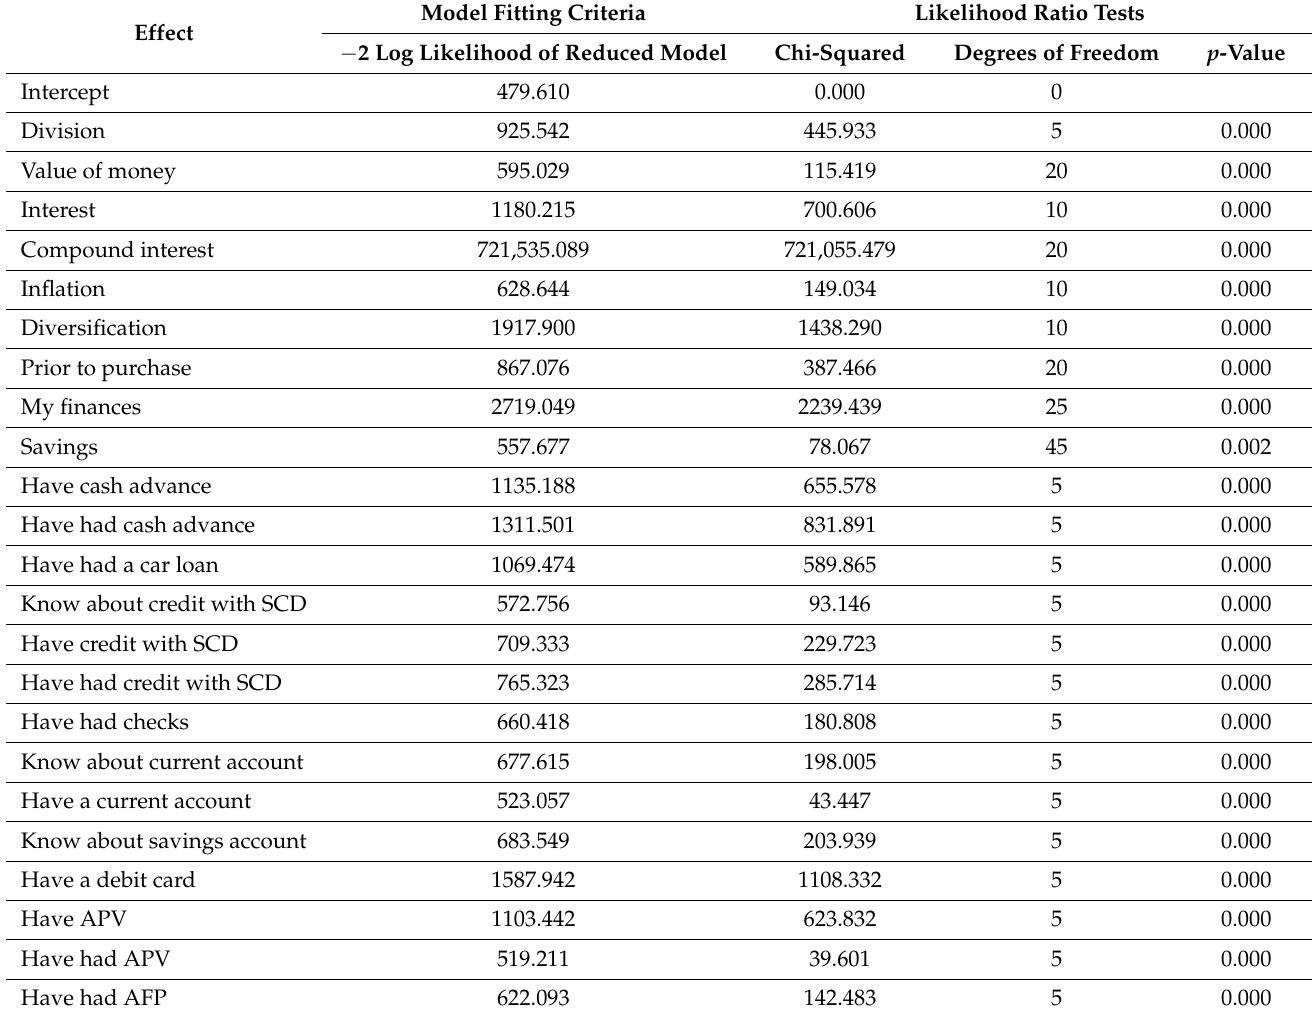
Table 3. Multinomial logistic regression of citizen